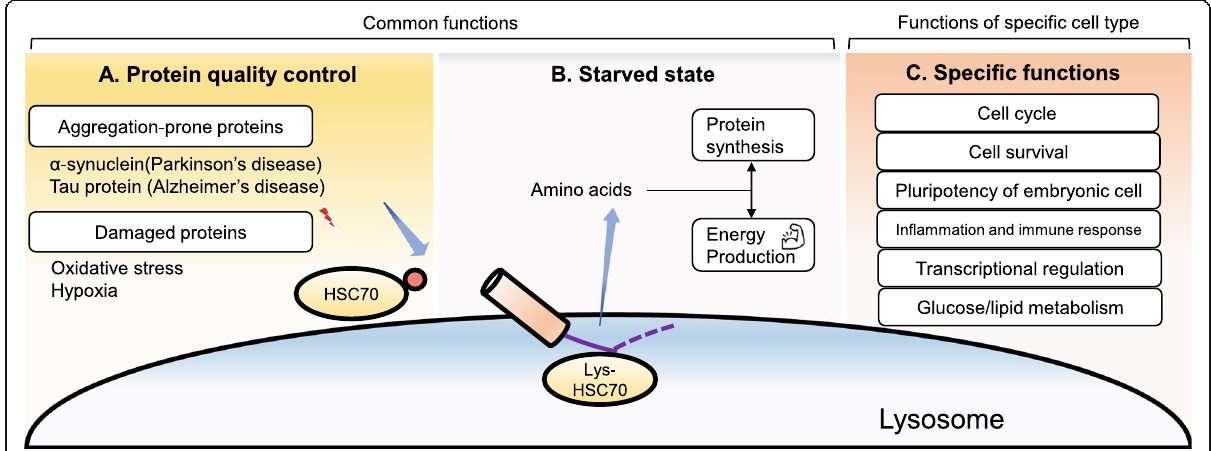
Fig. 2 Physiological roles of CMA. CMA has an essential role in physiological processes, including proteostasis, cellular energetics, cell cycle, cell survival, cell stemness, immune responses, and metabolic